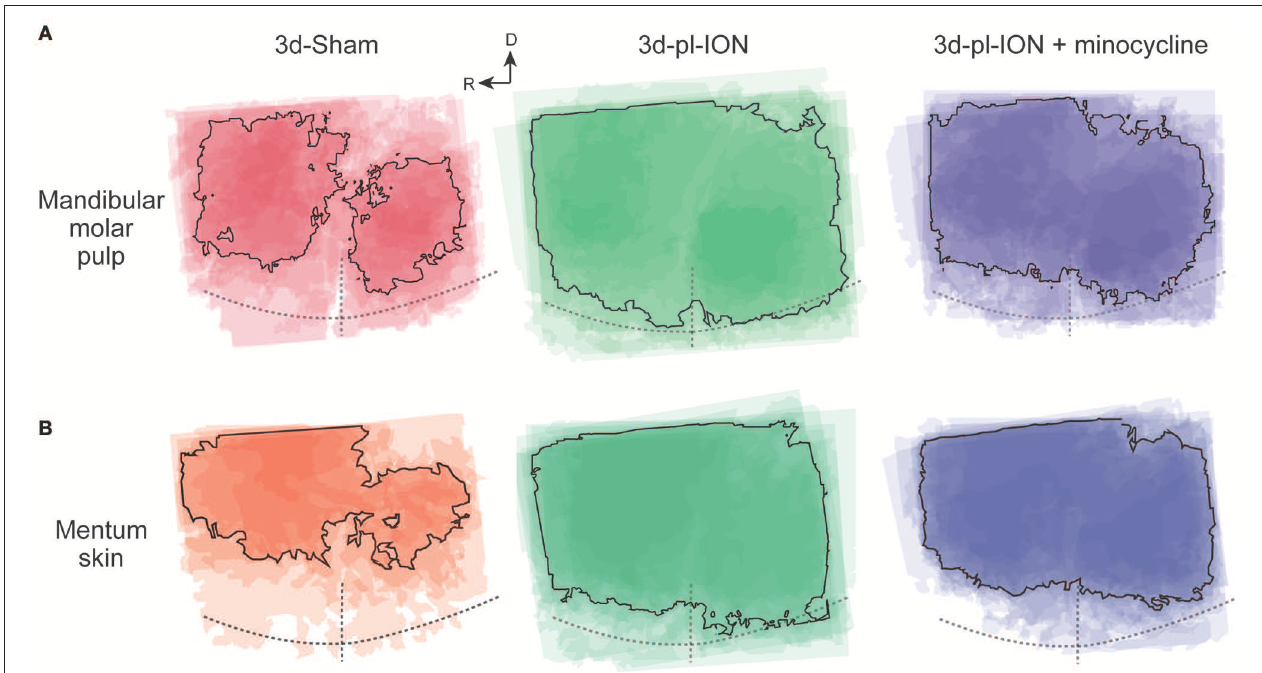
FIGURE 4 | Spatial profile of cortical responses to electrical stimulation of the mandibular molar pulp and mentum skin. (A,B) Superimposed images of the maximum responses evoked by the mandibular molar pulp stimulation (A) and mentum skin stimulation (B) in 3d-Sham, 3d-pl-ION, and 3d-pl-ION + minocycline. R, rostral; D,